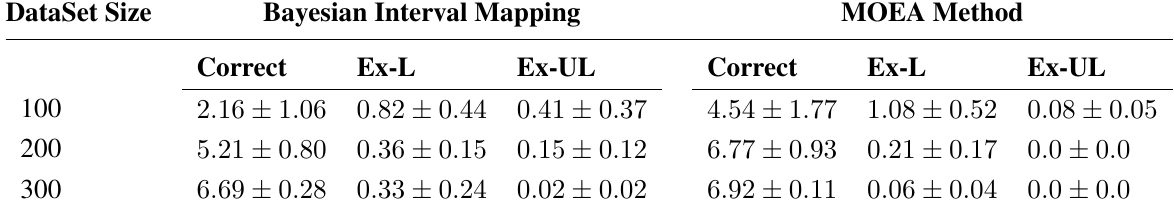
Table 2. Case I: MOEA vs . Bayesian Interval Mapping: Comparative results of the MOEA approach vs . Bayesian Interval Mapping method using Windows QTL